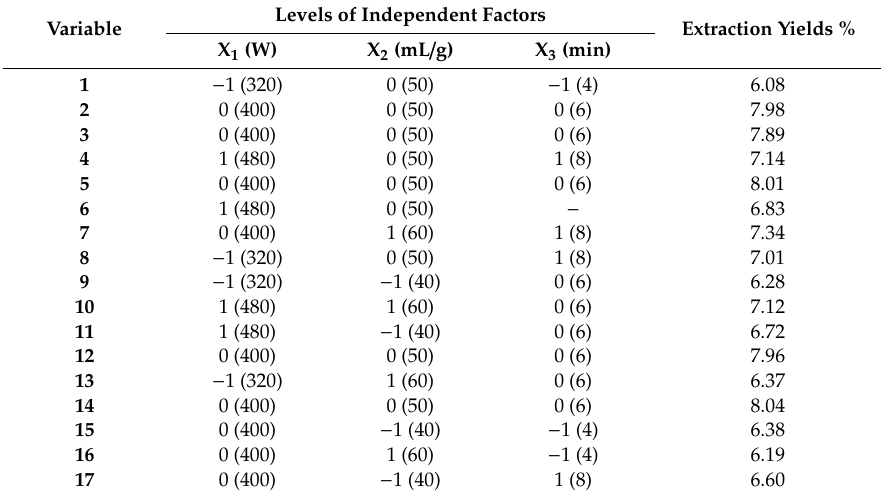
Table 1. Box-Behnken design with independent variables and observed values for microwave-assisted extraction (MAE).